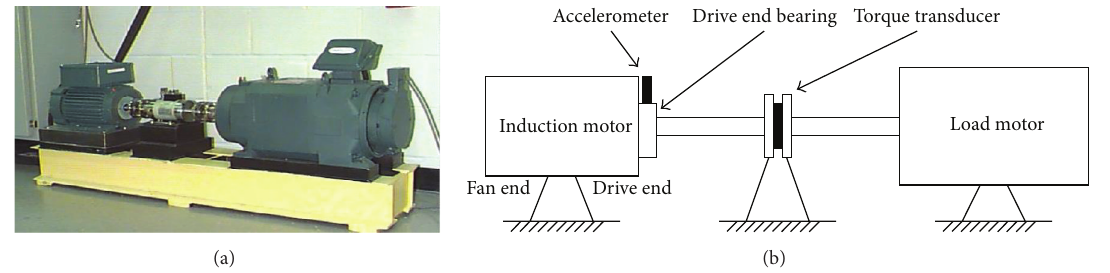
Figure 1: Experimental setup: (a) test rig; (b) schematic description of the test rig.